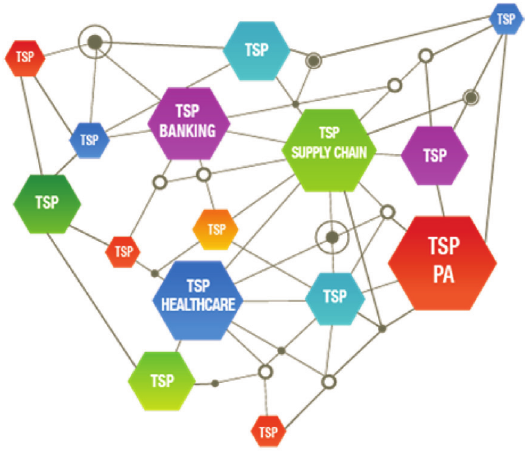
Figure 1: The TrustedChain®